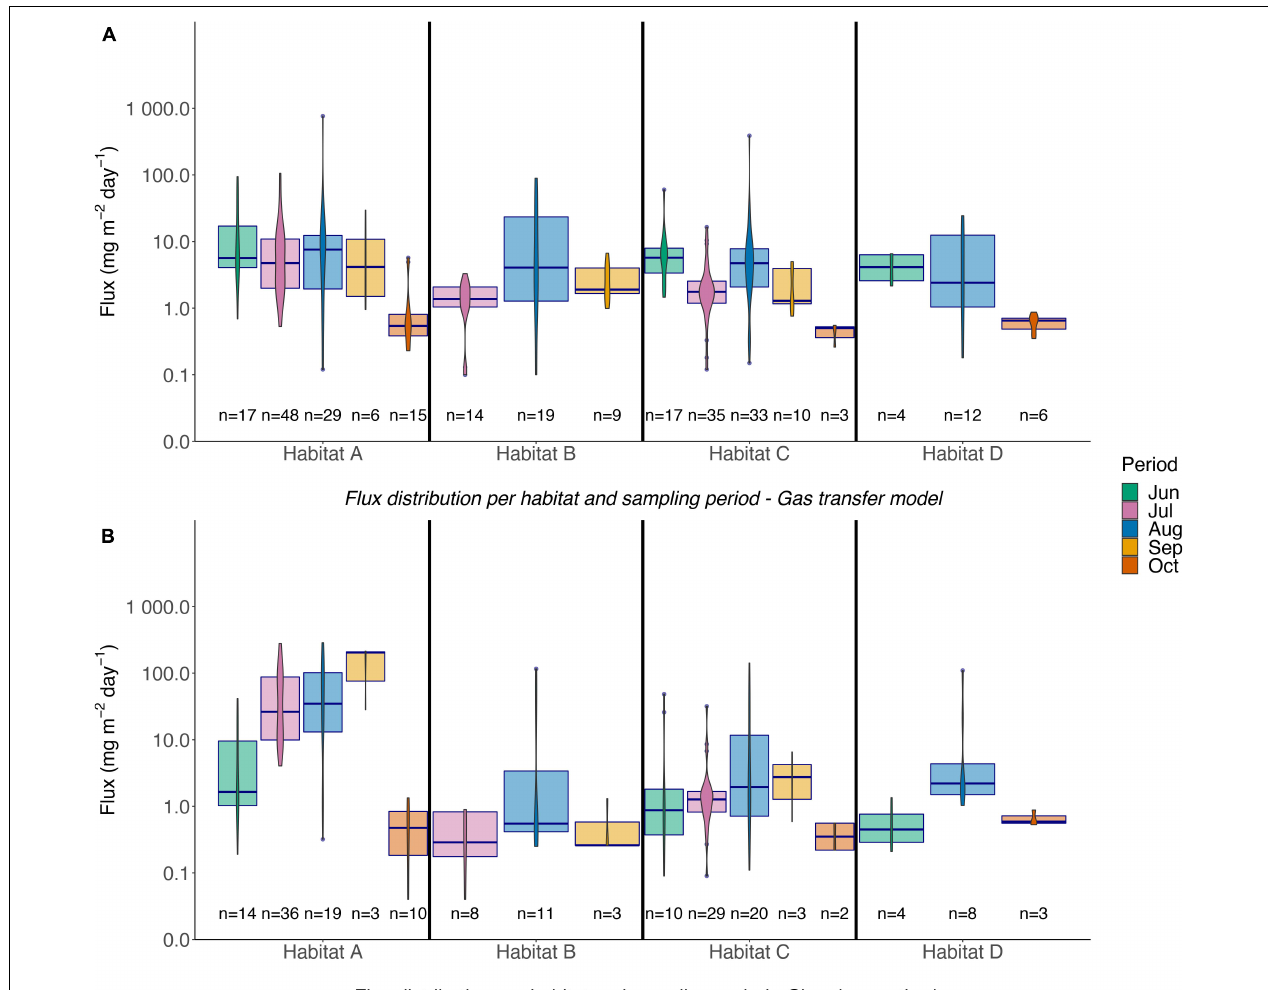
FIGURE 4 | (A,B) Flux variation in different habitats and sampling periods based on the gas transfer model and the chamber